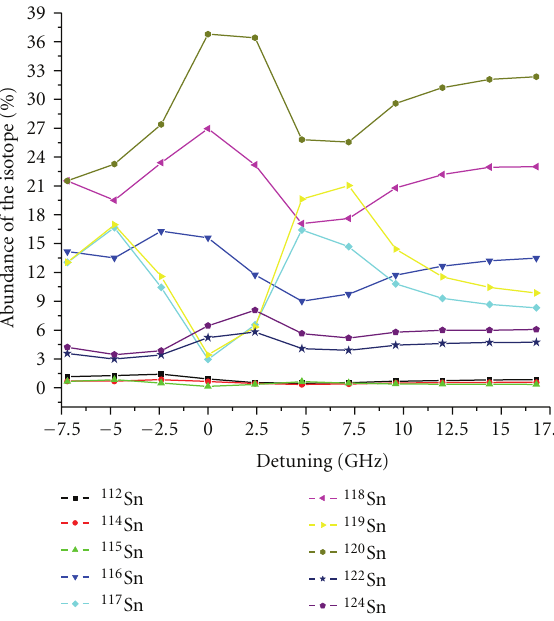
Figure 8: Experimental abundance of the tin isotopes as a function of laser detuning for the 286.3317nm transitionfor a laser linewidth of 2400MHz and a residual Doppler width of